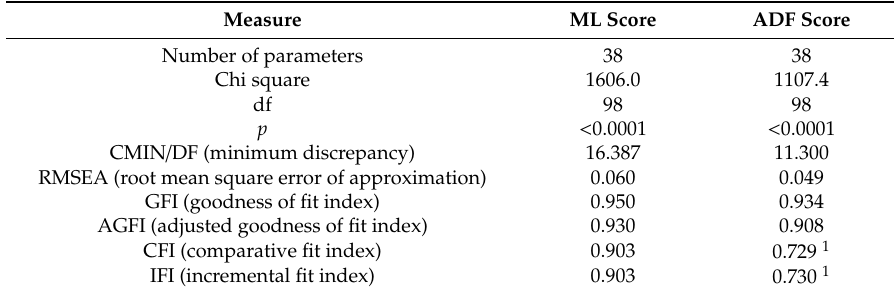
Table 6. Characteristics and goodness-of-fit statistics for the four-factor